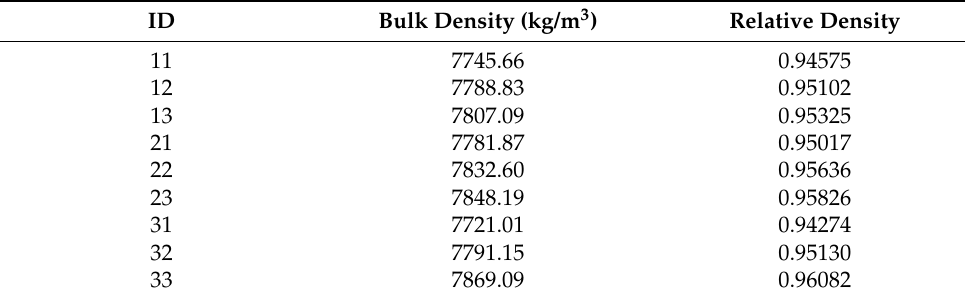
Table 7. Bulk and relative density of the fabricated specimens.